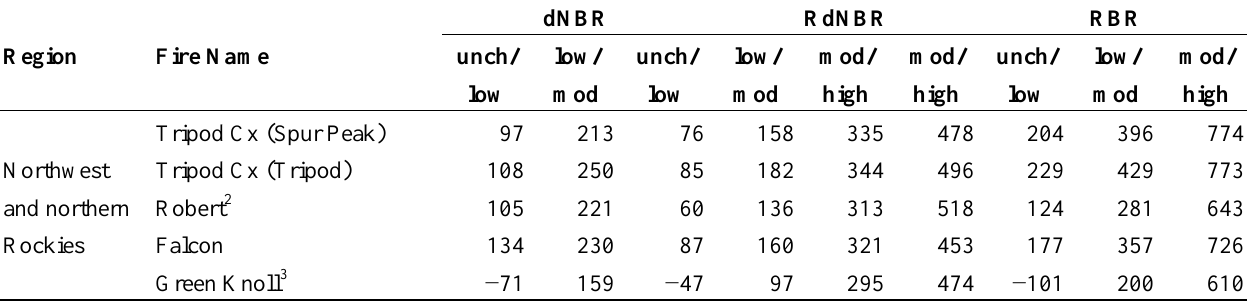
Table A2. Thresholds for the three remotely sensed burn severity metrics when the dNBR term was excluded from the equations corresponding to CBI = 0.1 offset (unchanged/low), 1.25 (low/moderate) and 2.25 (moderate/high) for each fire.